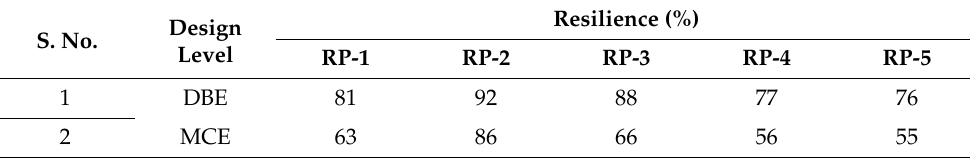
Table 13. Building resilience with respect to each design level corresponding to Case II. S. No.